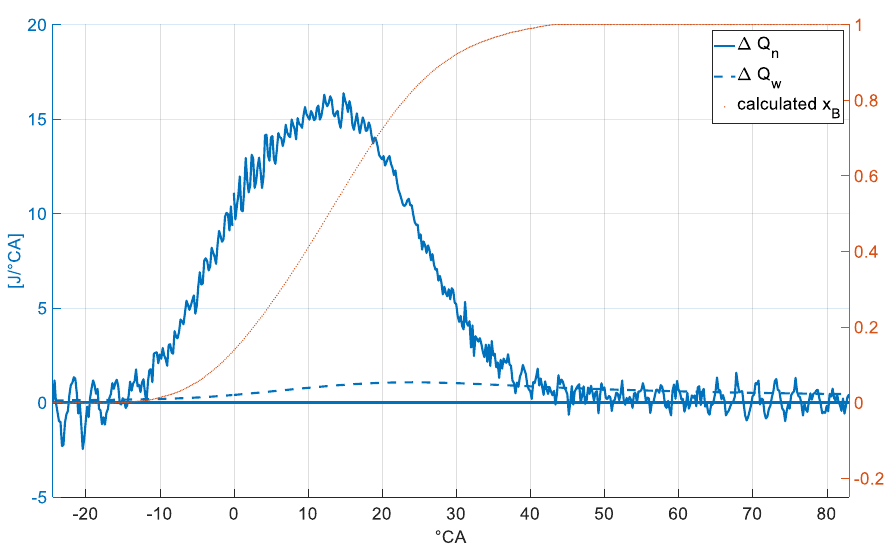
Figure A1. Mass fraction burned calculation.